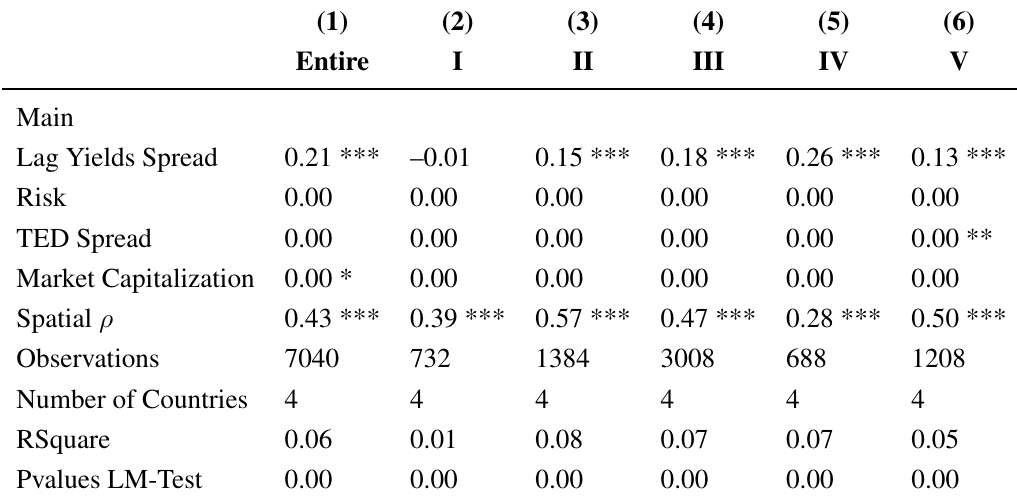
Table 4. Empirical results for highly exposed countries to the sovereign debt crisis excluding Greece.